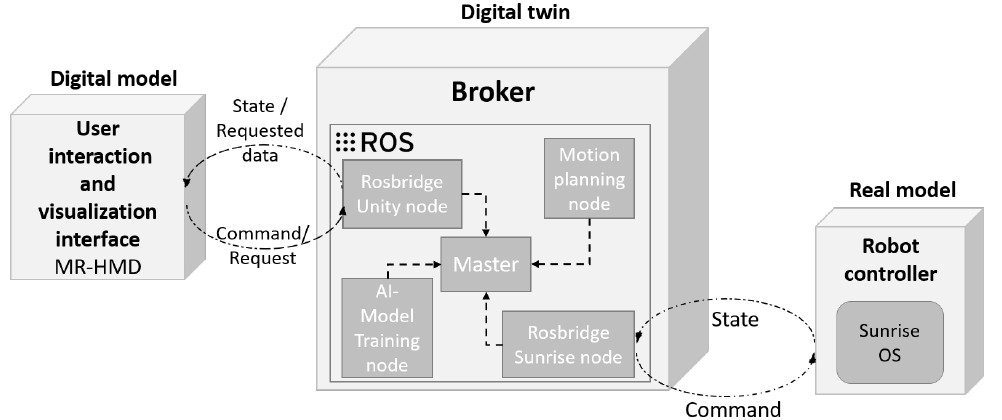
Figure 4. The use case architectural prototype of the DT